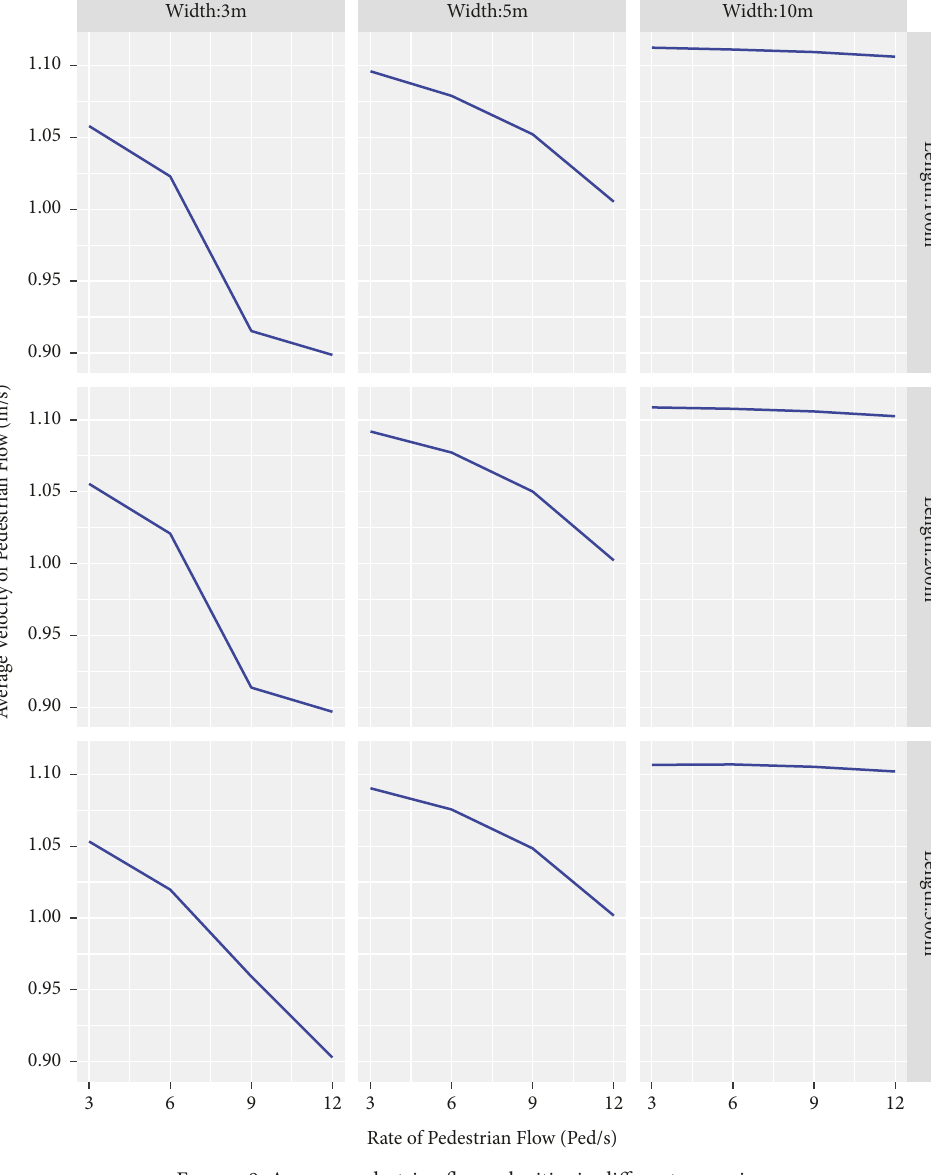
Figure 9: Average pedestrian flow velocities in different